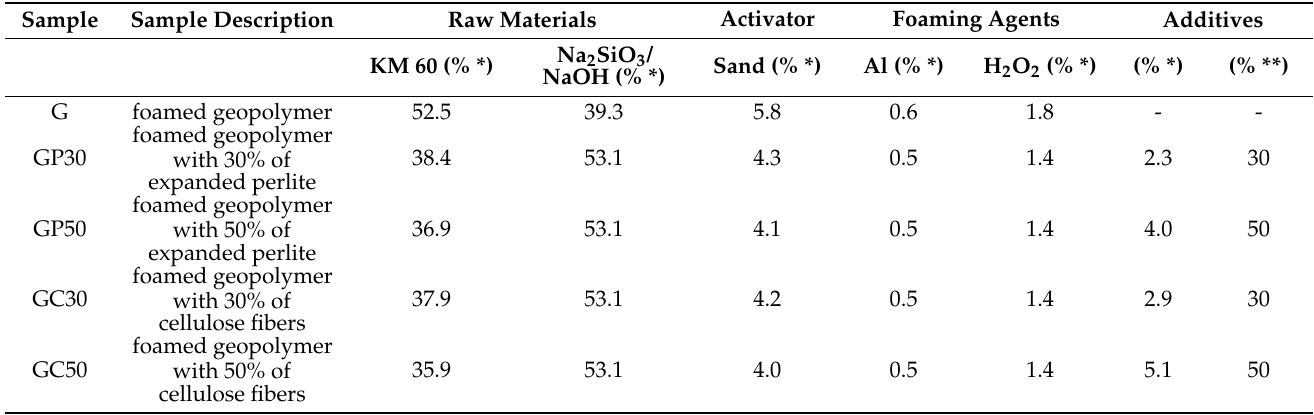
Table 2. Rate of raw materials, foaming agent, activators, and additives used to produce geopolymer and